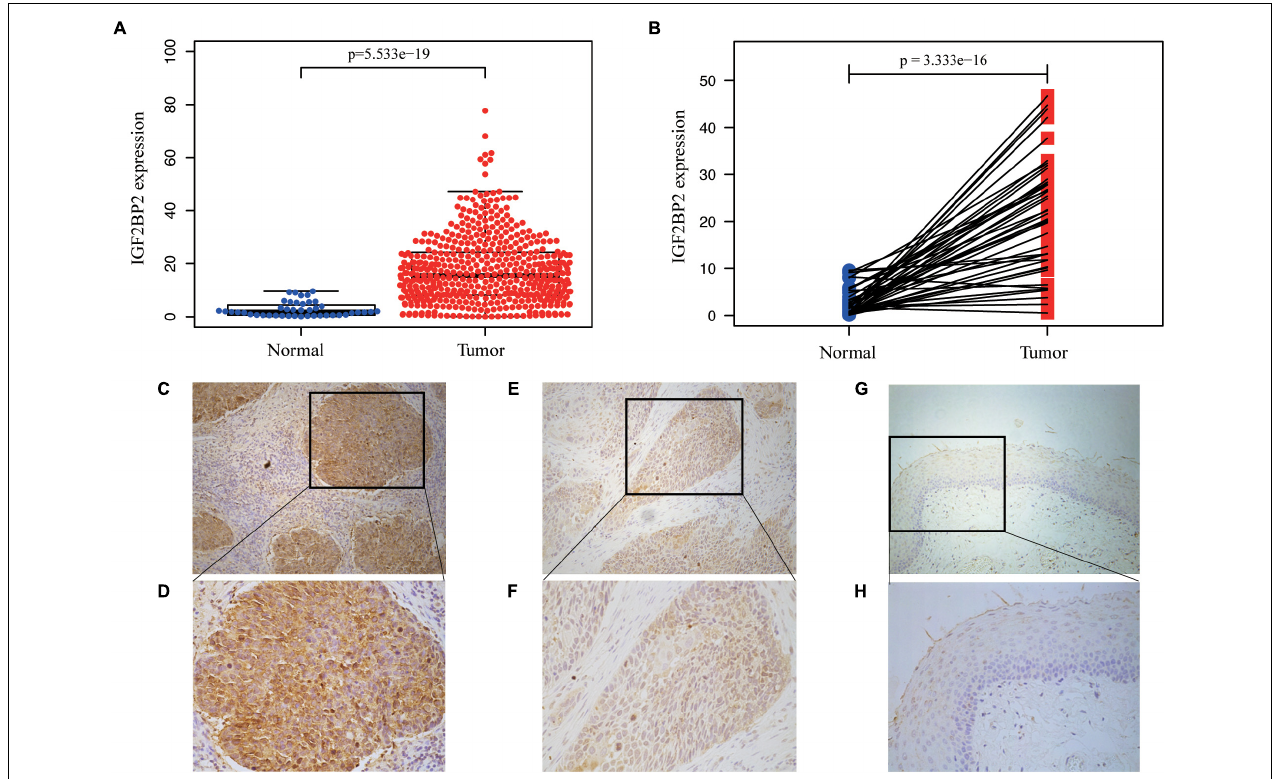
FIGURE 2 | IGF2BP2 is overexpressed in HNSCC. (A) 354 high IGF2BP2 mRNA expression in HNSCC based on TCGA DATA. (B) Paired difference analysis of IGF2BP2 mRNA expression in HNSCC based on TCGA DATA. (C,D) Representative immunohistochemical staining for IGF2BP2 protein in 36 matched HNSCC tissues and corresponding adjacent non-cancerous epithelial tissues. High expression of IGF2BP2 protein in primary HNSCC specimens (200x, 400x). (E,F) Low expression of IGF2BP2 protein in HNSCC specimens (200x, 400x). (G,H) Negative expression of IGF2BP2 in adjacent non-cancerous epithelial tissues (200x, 400x).